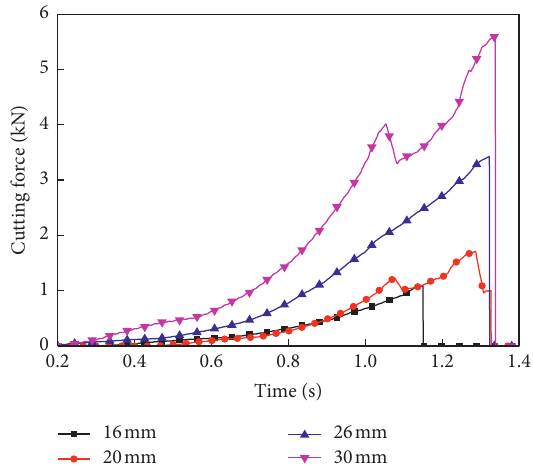
Figure 15: Variation in cutting force with time at different thickness.